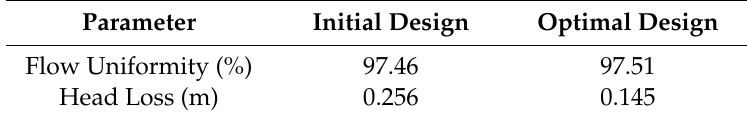
Table 10. Results of casing optimization for the 100 MW class Francis turbine.